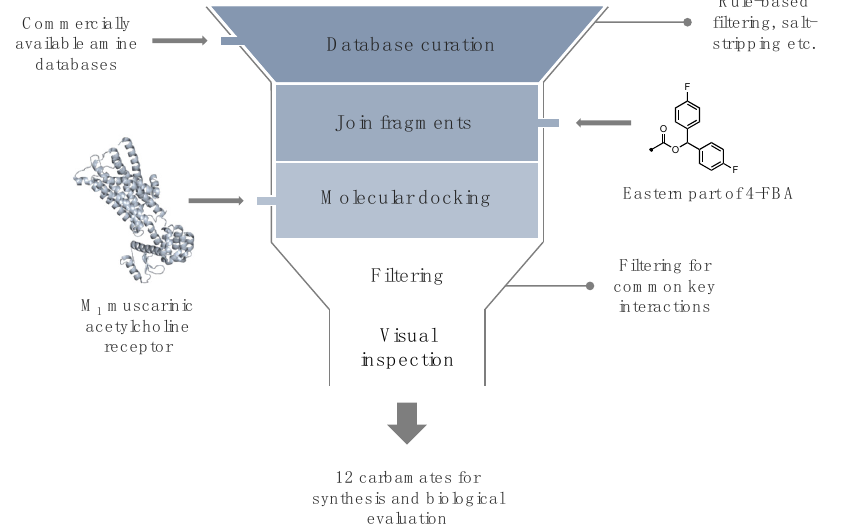
Figure 3. Schematic depiction of the utilized in silico workflow in this study. Overall, the selected carbamates 1 – 12 engage in similar pharmacophoric interactions with the orthosteric binding site of the M 1 muscarinic receptor. Compound 2 adopts an extended pose, engaging with many of the residues featured in the binding mode of tiotropium (Figure 4a,b) [18]. As required by our post-docking filter, the 1,4-diazepane’s N -methyl ammonium group forms a salt bridge with Asp105 3.32 ; however, unlike many known agonists and antagonists, 2 does not interact with Asn382 6.52 [24], instead it is predicted to form a hydrogen bond with Cys407 7.42 . In fact, this interaction with Cys407 7.42 together with a fluorine–hydrogen bond with Thr189 5.39 is shared among the whole com- pound selection except for 5 (Supplementary Materials, Figure S1). The carbonyl oxygen of spirocyclic 5 , by contrast, acts as a hydrogen bond acceptor for Tyr106 3.33 . Compounds 3 , 4 , and 8 not only engage in hydrogen bonding with Cys407 7.42 , but form yet another hydrogen bond with Asn382 6.52 (Supplementary Materials, Figure S1d,f,l). While the fluorinated benzhydrol part of the molecules 2 and ( R )- 7 adopt an almost identical pose, occupying the binding site’s two lipophilic pockets, the ammonium groups differ slightly in their spatial position attributable to the different ring geometries (Figure 4c). Compared to 2 , the protonated amine of ( R )- 7 ’s piperidine ring is tilted, enabling another favorable cation– π interaction with Tyr404 7.39 , a key interaction in many known muscarinic ligands (Figure 4d) [21]. The enantiomeric pairs of the secondary carbamates 7 and 9 – 12 are pre- dicted to adopt largely overlapping poses (Supplementary Materials, Figure S2). Since it was difficult to identify any stereospecificity of the pharmacophore from those, we decided to move along with the racemic versions of the aforementioned compounds at this stage, having the additional benefit of speeding up the biological testing.